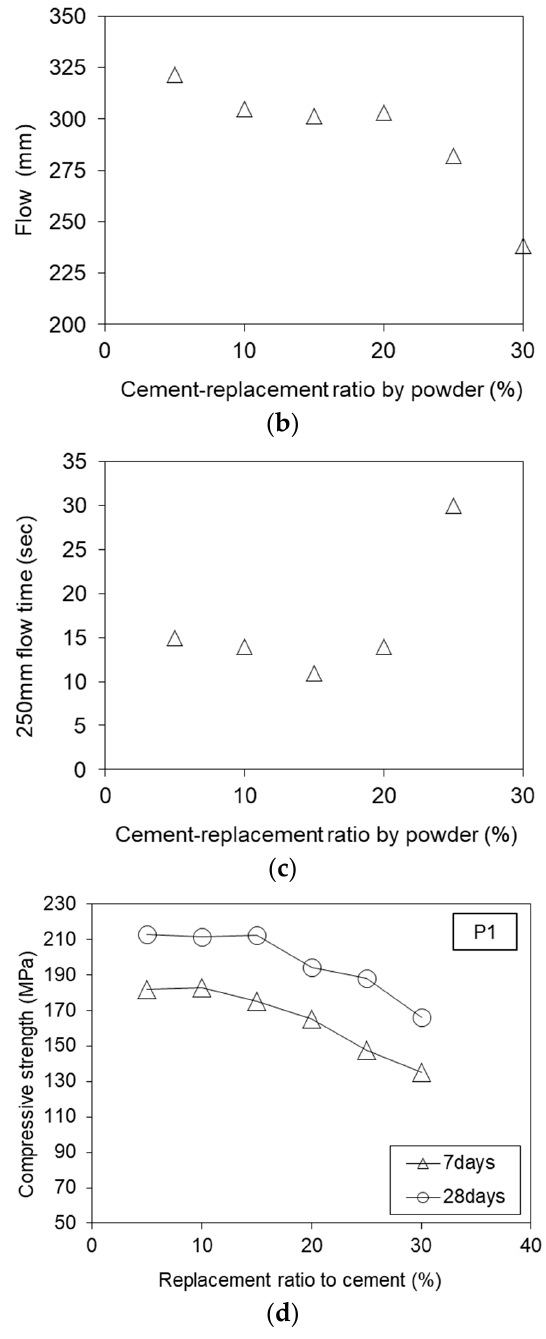
Figure 17. Effect of P1 addition ratio. ( a ) HRWRA. ( b ) Mortar flow. ( c ) Two-hundred-and-fifty- millimetre flow time. ( d ) Compressive strength.